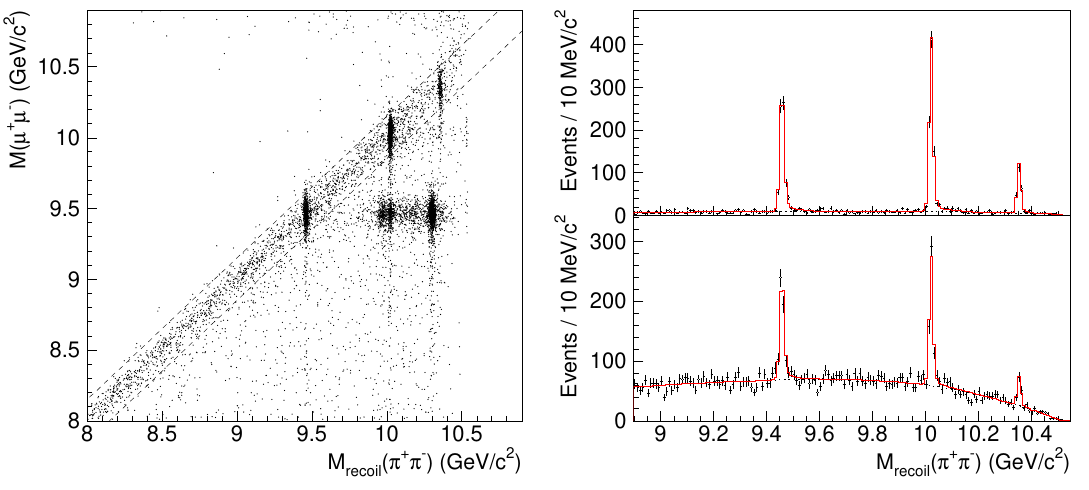
Figure 1 . Left: M ( (cid:22) + (cid:22) (cid:0) ) vs. M recoil ( (cid:25) + (cid:25) (cid:0) ) distribution in a high-statistics data sample (No. 9 in table 1). Dashed lines show a diagonal band selected by the requirements of eq. (3.2). Right: M recoil ( (cid:25) + (cid:25) (cid:0) ) distributions for the selected (cid:22) + (cid:22) (cid:0) (cid:25) + (cid:25) (cid:0) (top) and e + e (cid:0) (cid:25) + (cid:25) (cid:0) (bottom) candidates. Results of the (cid:12)t (red solid histogram) and background component of the (cid:12)t function (black dotted histogram) are also